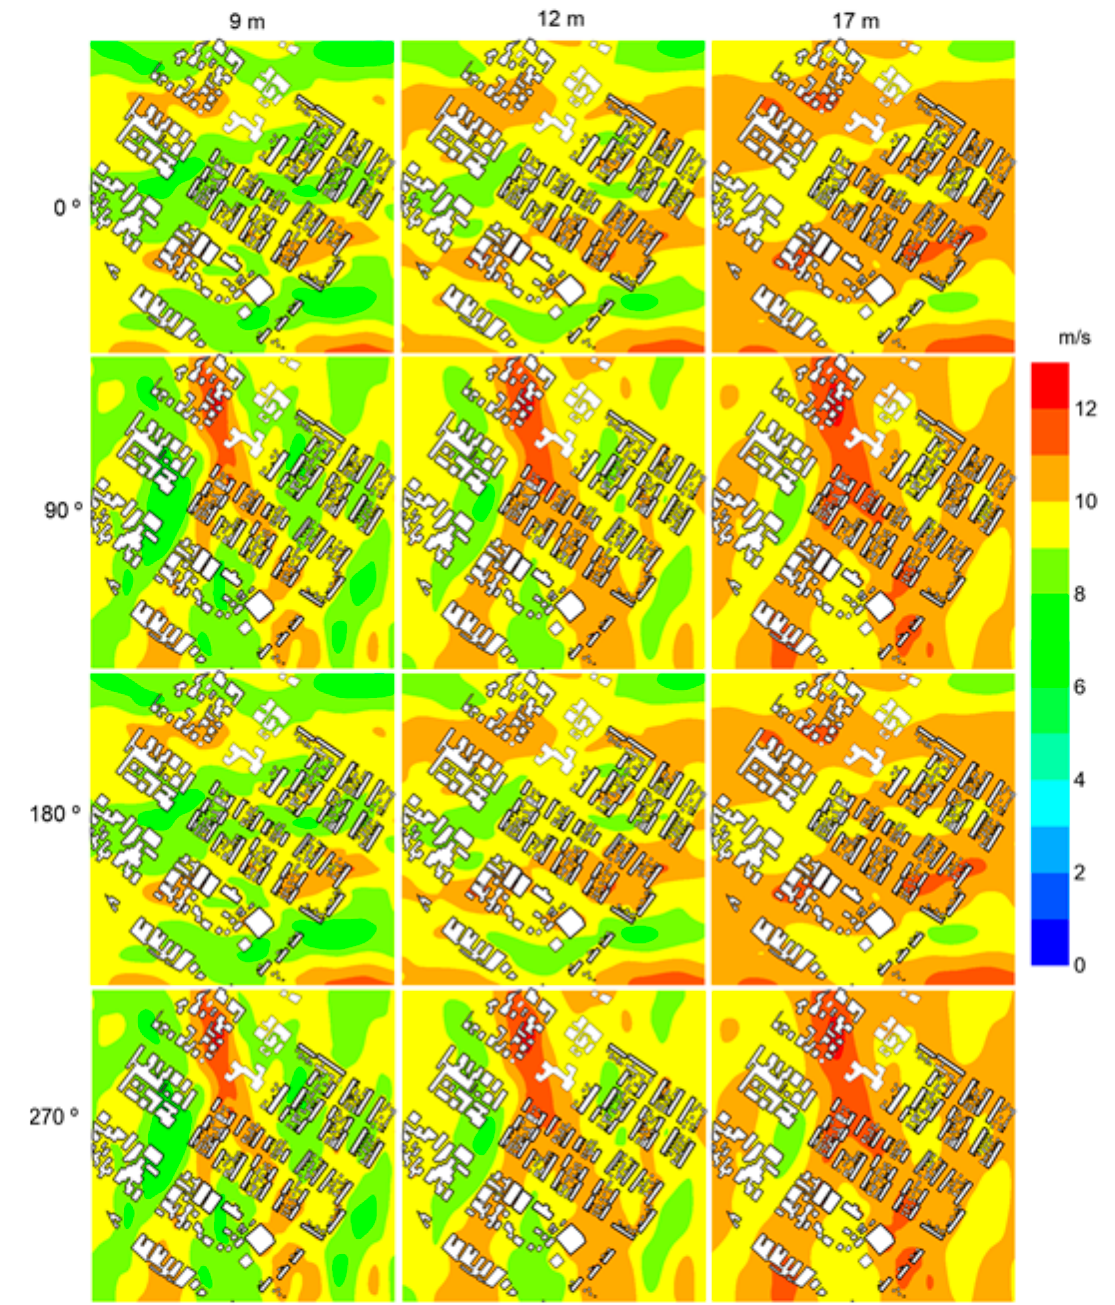
Figure 20. Mean wind speed estimates obtained by the WAsP Engineering model for three heights (9 m, 12 m, and 17 m) and four wind sectors rose (0 ◦ , 90 ◦ , 180 ◦ , and 270 ◦ ). In terms of mean deviation values, from Figures 21–23, one observes a different behavior between deviation from velocity and turbulence intensity. While for wind, the mean deviations decrease with height, the turbulence intensity shows the opposite. The WindSim model also tends to overestimate the wind deviations through all points and heights but underestimates the turbulence intensity over all heights except at h = 9 m, where there is a tendency to overestimate sectors N and S (0 ◦ and 180 ◦